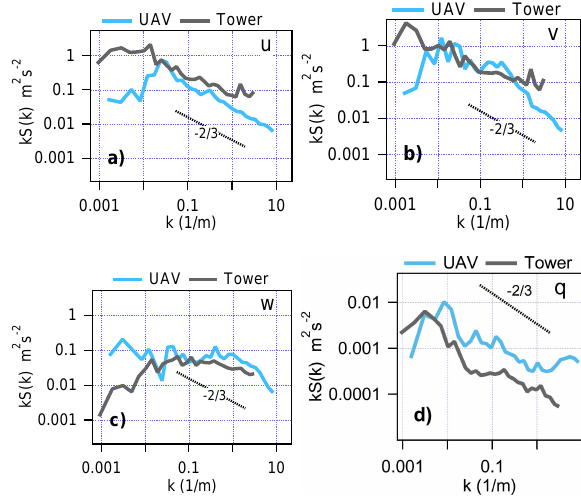
Fig. 6. Composite smoothed power spectra, kS ( k ), of unfiltered wind components ( u , v , w ) and water vapor, q , from flux legs at 520ma.g.l. compared to surface spectra between 09:30–10:00a.m., a period when ζ < 1. Similar spectral structures appear at both alti- tudes across the bandwidth with magnitudinal departures at the low and high frequency